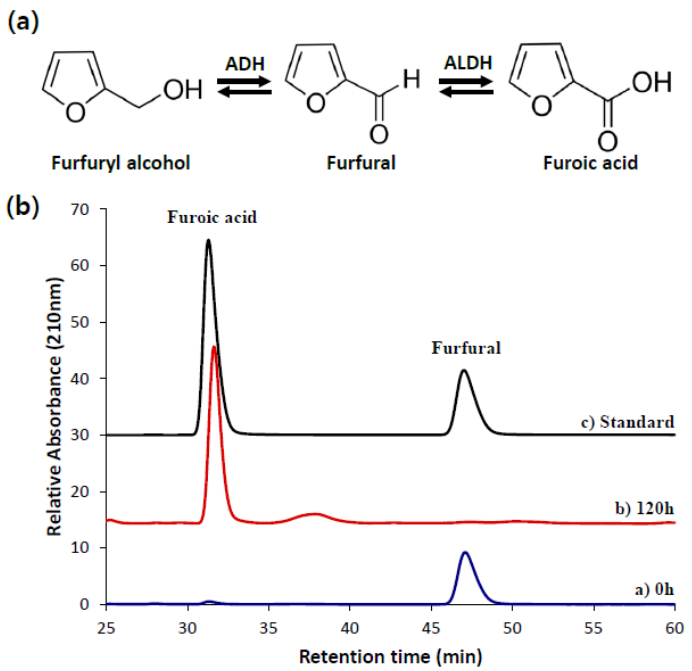
Figure 2. The hypothesized mechanism ( a ) of furfural detoxification in Y. lipolytica by either ADH or the ALDH converting furfural into furfuryl alcohol or furoic acid, respectively. The HPLC chromatograms ( b ) of the sample from the control strain expressing empty plasmid at the initial (0 h) and 120 h of incubation under a furfural stress condition.